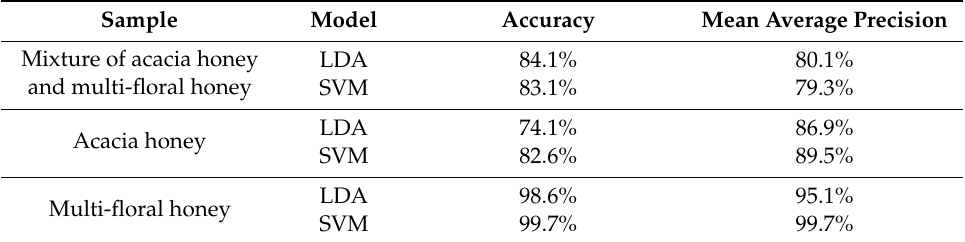
Table 3. Discriminant results of honey